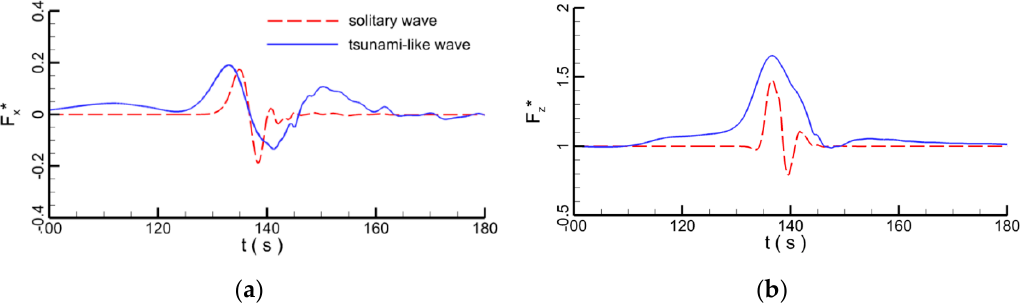
Figure 16. Time series of hydrodynamic forces at a pipeline under tsunami-like and solitary waves; ( a ) horizontal force F x *; ( b ) vertical force F z *.